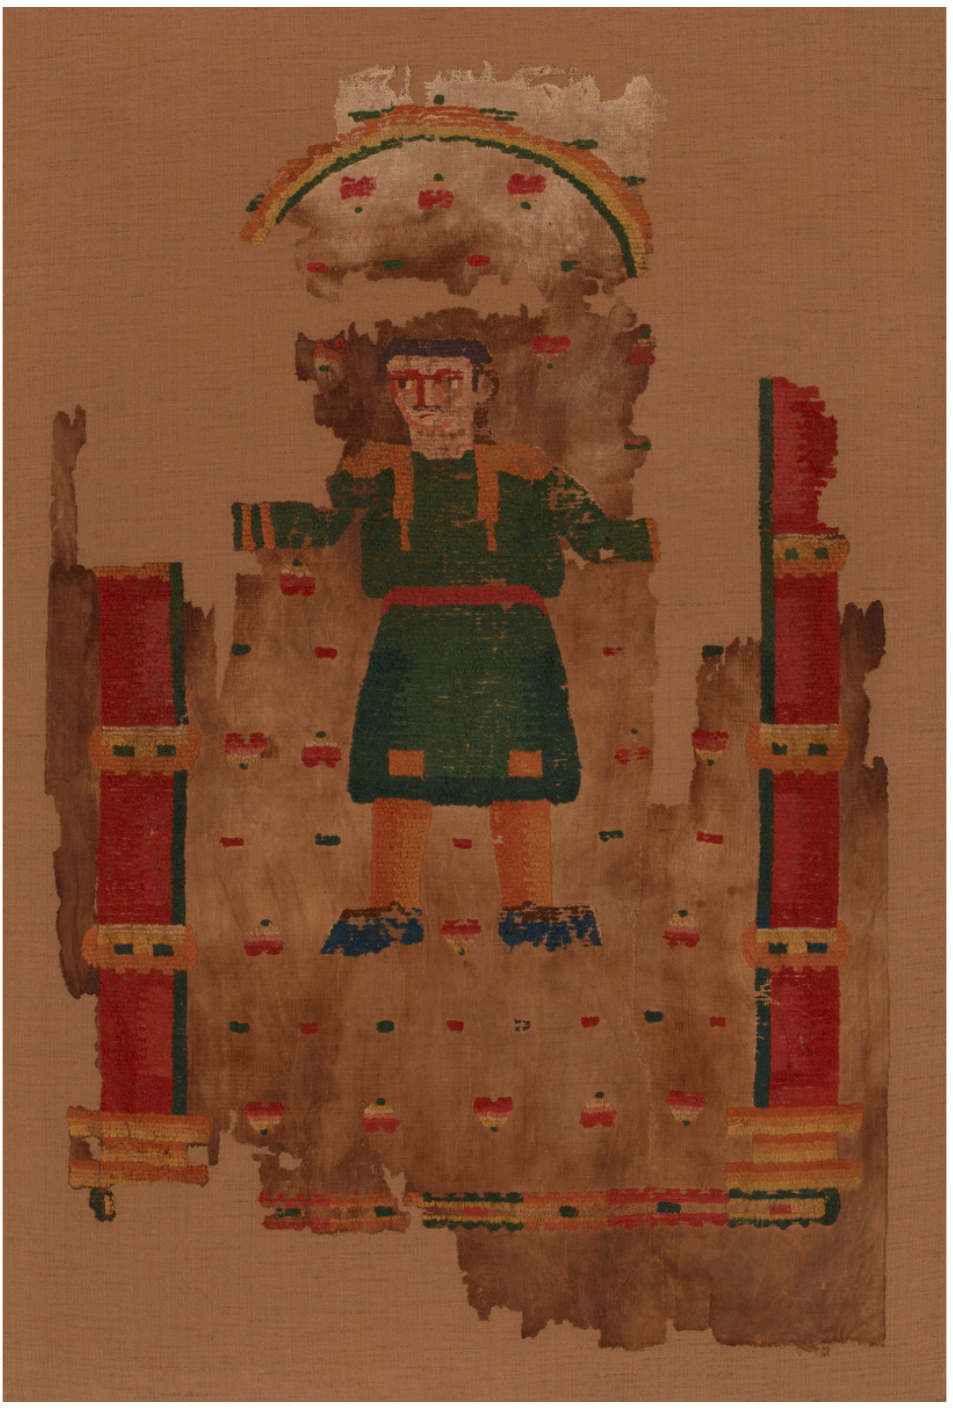
Figure 1. Fragment of a Hanging , 5th–6th century CE. Byzantine; Egypt. Linen and wool, plain weave with weft uncut pile and embroidered linen pile formed by variations in back and stem stitches; 136.5 × 88.3 cm (53 3/4 × 34 3/4 in.). The Art Institute of Chicago, Grace R. Smith Textile Endowment, 1982.1578.